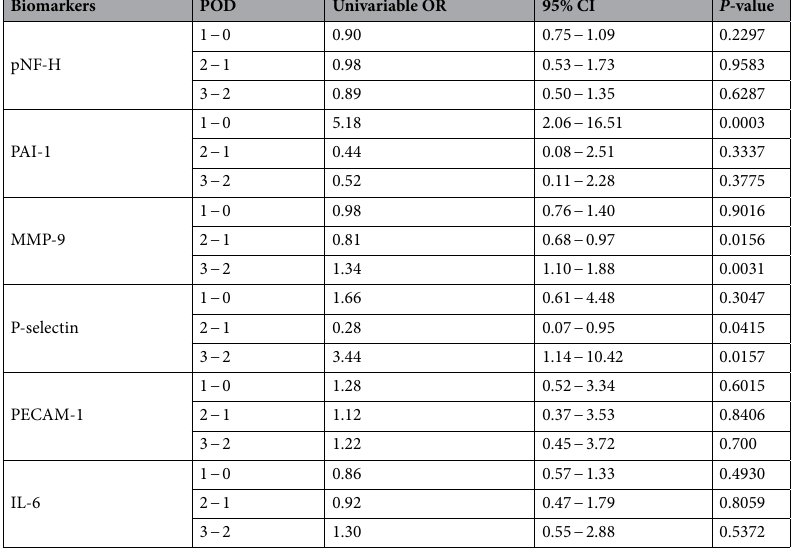
Table 1. Logistic regression analysis for prediction of postoperative delirium. Difference in the log- transformed levels of each biomarker between indicated postoperative days were calculated using subtraction. 1 − 0, subtraction of preoperative pNF-H values from those on postoperative day 1; 2 − 1, subtraction of values on postoperative day 1 from those on postoperative day 2; 3 − 2, subtraction of values on postoperative day 2 from those on postoperative day 3. Abbreviations: POD postoperative day; OR odds ratio; CI confidence interval; pNF-H phosphorylated neurofilament heavy chain; PAI-1 plasminogen activator inhibitor-1; MMP- 9 matrix metalloproteinase-9; PECAM-1 platelet endothelial cell adhesion molecule-1; IL-6 interleukin-6. Sample size at each point is indicated in online Supporting Information Table S2. Preoperative (POD0) values of PAI-1, MMP-9, P-selectin, PECAM-1 and IL-6 come from the dataset published in Ref. 12